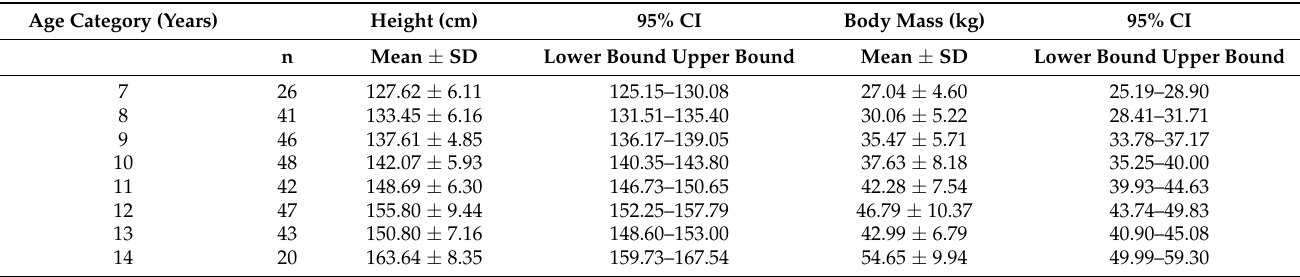
Table 1. Anthropometric